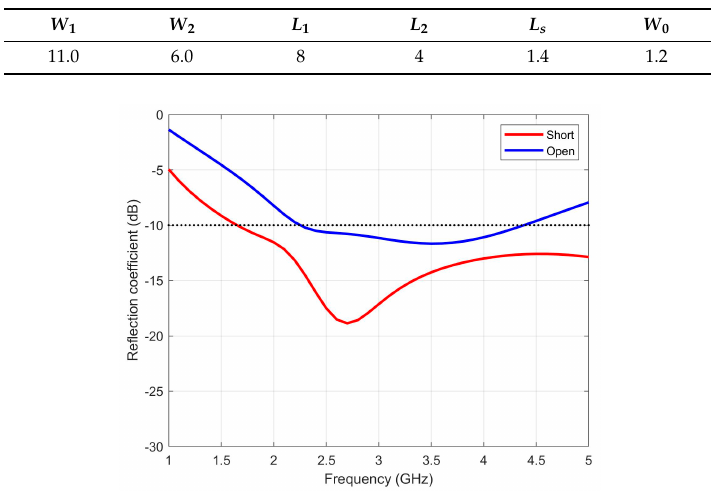
Table 1. Design Parameters of the Jerusalem Cross Antenna (in mm).